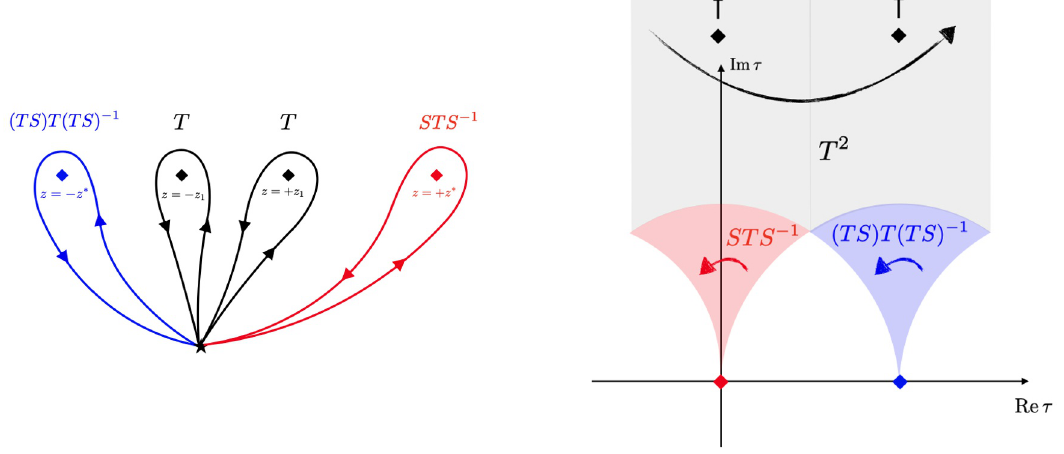
Figure 2. The left figure shows the location of the string cores in the setup corresponding to gluing two 2 AB solutions together. The two EFT string cores with monodromy T are located at z = ± z 1 whereas the two additional cores are located at z = ± z ∗ . Notice that the monodromy around the latter differs by conjugation with T . The right figure shows the corresponding image in the upper half plane Im τ > 0 with the two EFT string cores corresponding to the cusp at τ = i ∞ and the other two corresponding to the cusps at τ = 0 and τ = 1